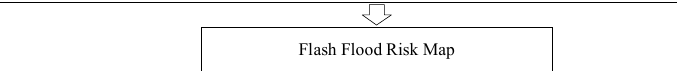
Figure 7. Flowchart of the Risk Computational Model.